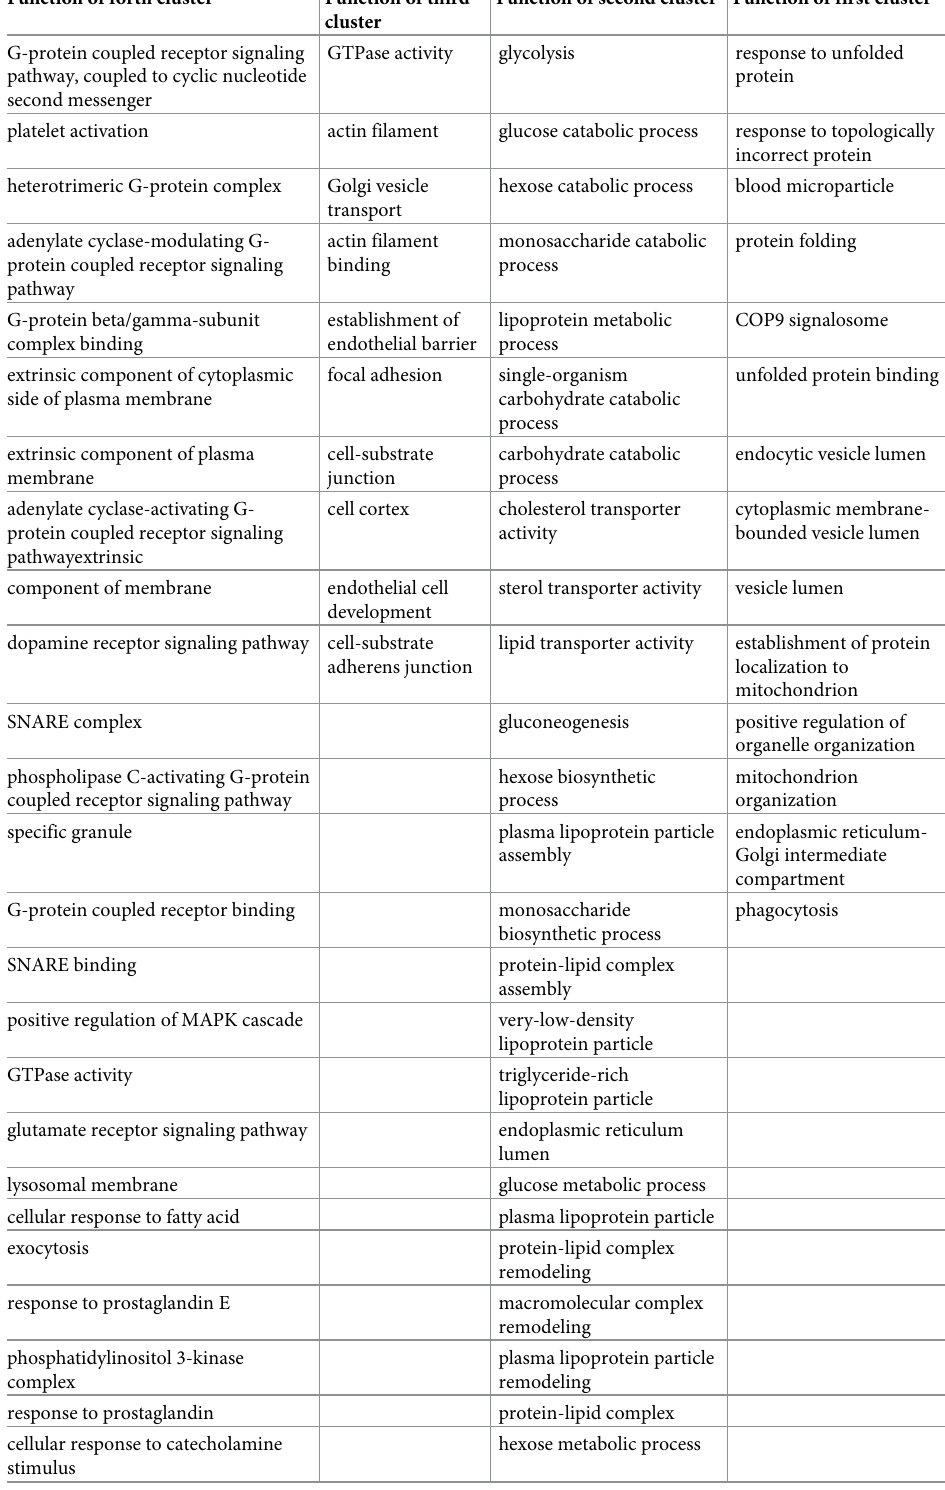
Table 3. Exploration of gene functions within the four evidence accumulation